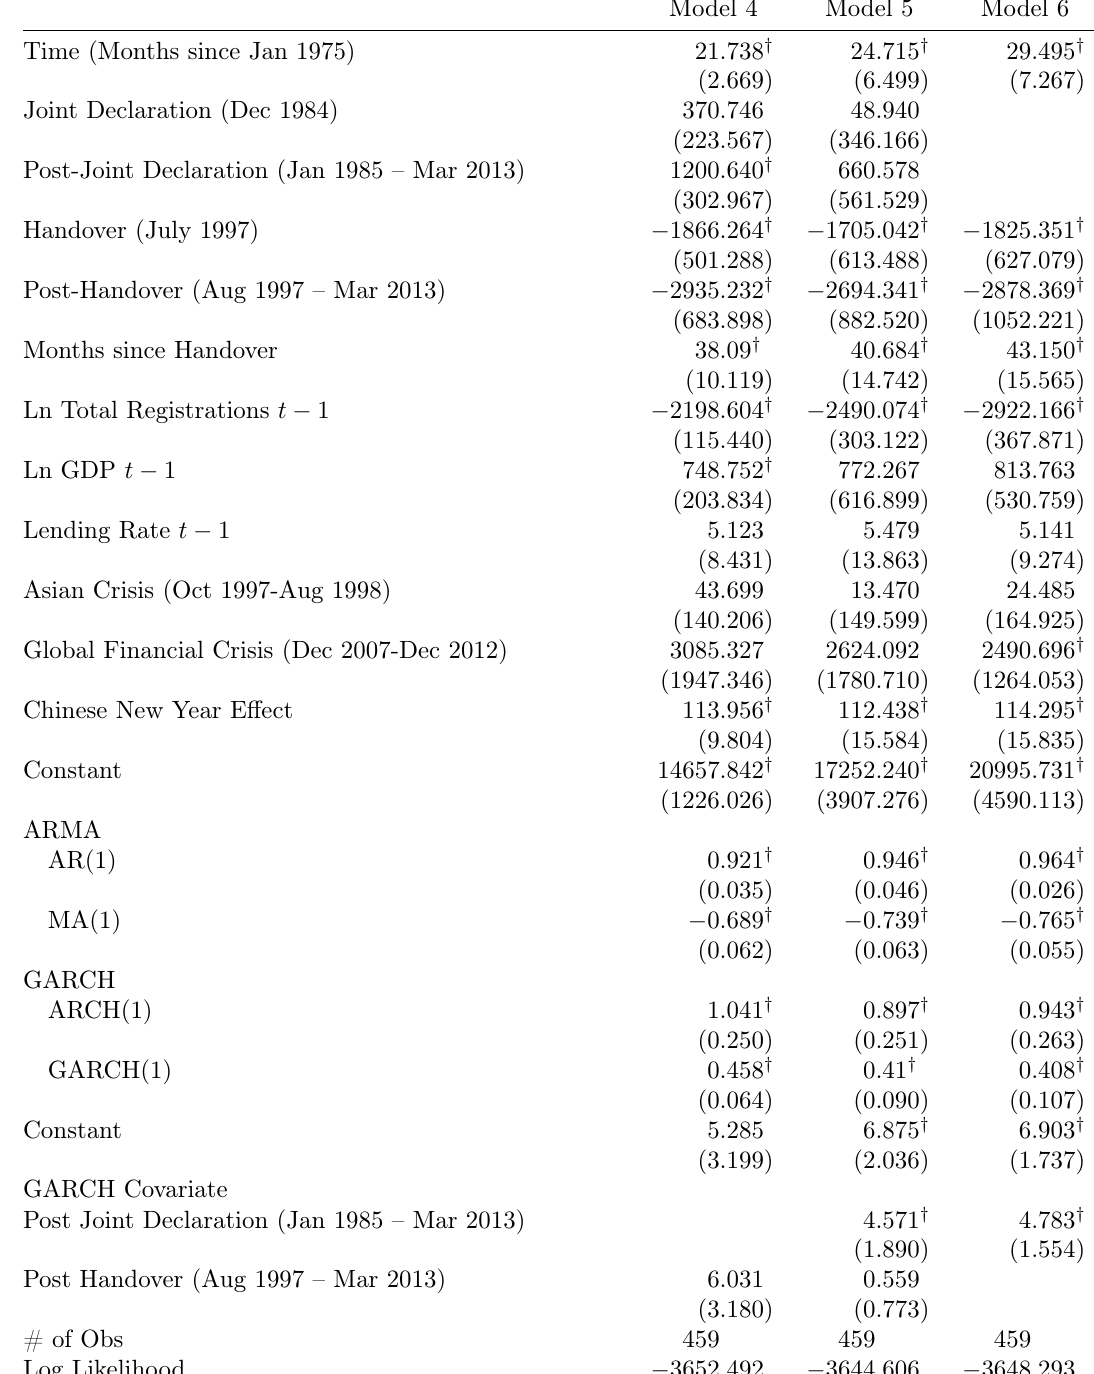
Table 2: GARCH Estimates of Effects of Source of Temporal Volatility on New